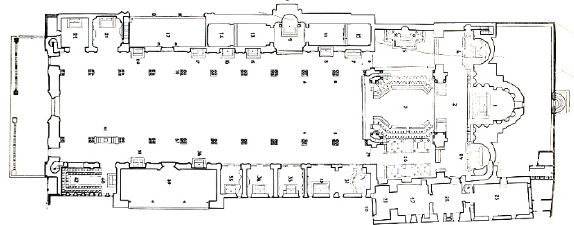
Figure 4. Plan of the Cathedral of Palermo before the 18th renovation (Zanca, 1952). The section of Gagini’s ‘Tribuna’ and its niches appears in the main apse.